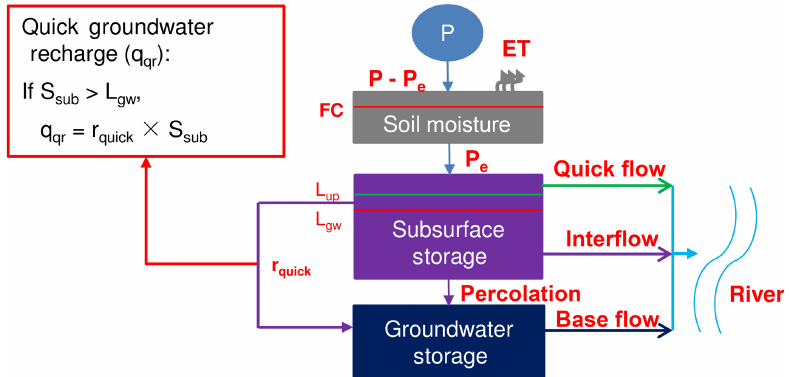
Figure A1. The hydrological model for the Ammer catchment with three storage zones (soil moisture, subsurface storage, and groundwater storage), a quick groundwater recharge and an urban surface runoff